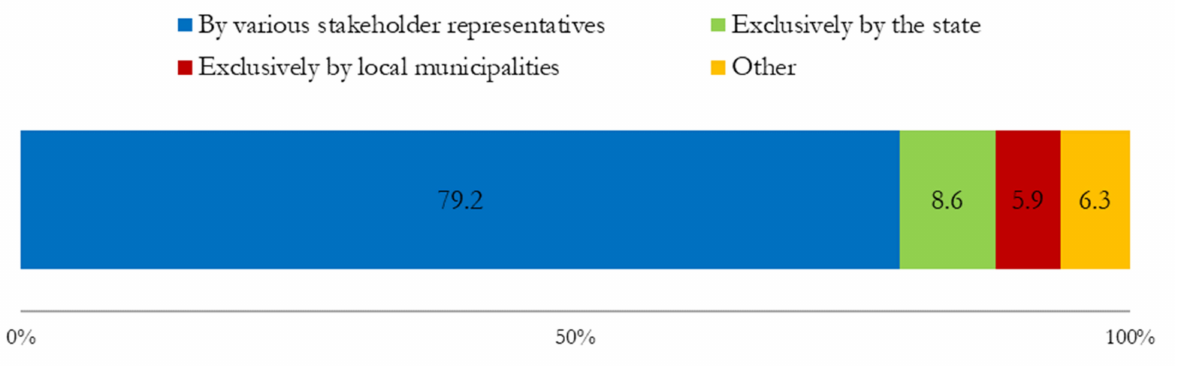
Figure 8. Stakeholders who should manage the Central Highlands National Park according to the tourism